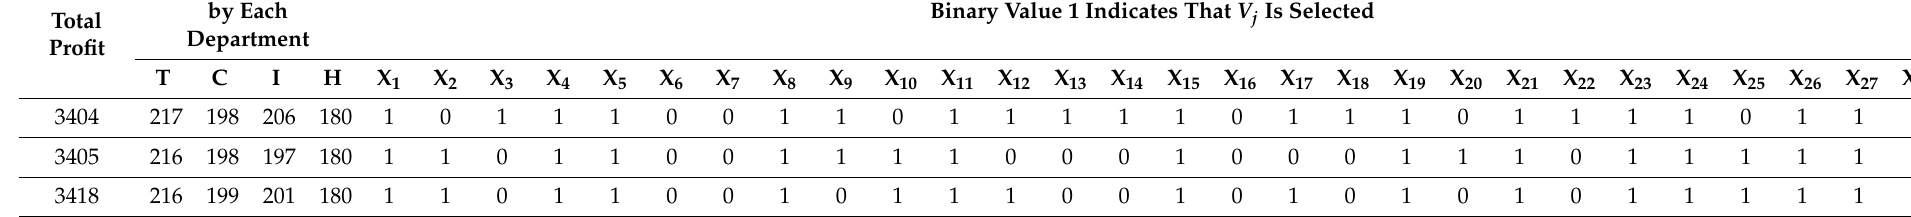
Table 7. Results for the HP1 benchmark problem using the SA